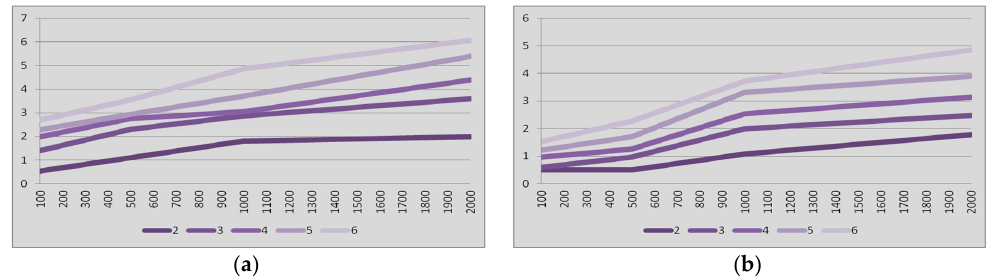
Figure 5. Latency (vertical, seconds) vs. inactivity interval (horizontal, milliseconds). Links always in park mode. From two to six hops: ( a ) master-to-slave communication; ( b ) slave-to-master